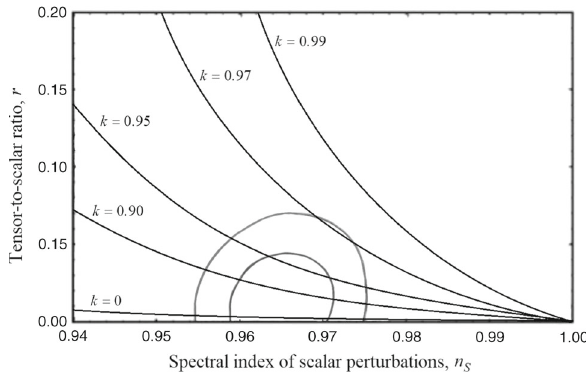
Fig. 1 The dependencies r = r ( n S ) for the different values of the parameter k with constraints on the tensor-to-scalar ratio r due to the Planck TT,TE,EE+lowE+lensing+BAO+BICEP2/Keck Array observa- tions